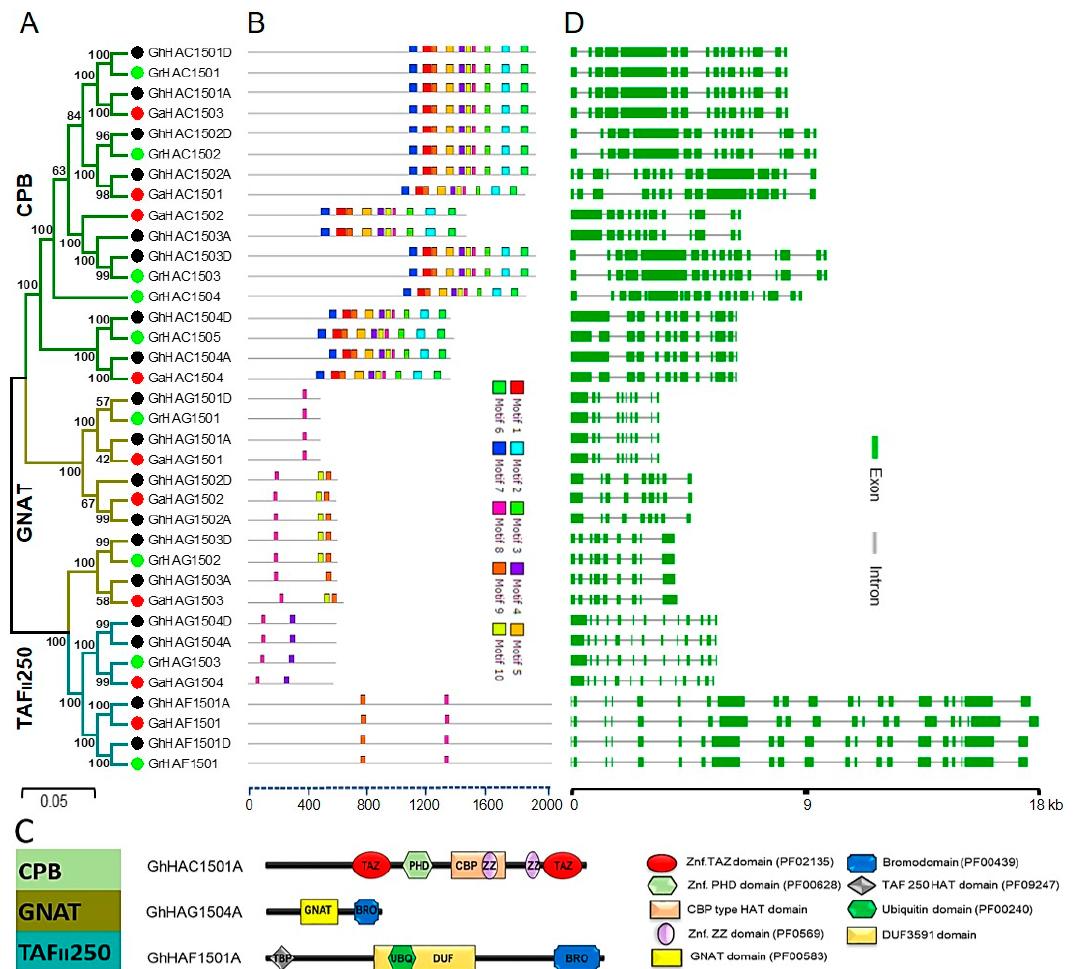
Figure 2. Phylogenetic relationships, conserved motifs, domain organization, and gene structure analysis of HATs in Gossypium hirsutum , Gossypium raimondii and Gossypium arboretum . ( A ) The unrooted phylogenetic tree was constructed using MEGA 6 by the NJ method, and the bootstrap analysis was performed with 1000 replicates. The HAT proteins from G. hirsutum , G. raimondii , and G. arboretum were marked with black, green and red dots, respectively. The branches of each subgroup were indicated in a specific color. ( B ) Motif identification analysis in HAT proteins from G. hirsutum , G. raimondii and G. arboretum . Each motif is shown in unique color, and the regular expression and sequences of the 1–10 motifs are listed in Figure S1. ( C ) Domain organization of HAT proteins from G. hirsutum , G. raimondii and G. arboretum . One representative of each subgroup of HAT from G. hirsutum is presented. ( D ) The intron / exon structure of HAT genes from G. hirsutum , G. raimondii and G. arboretum . The green boxes and grey lines represent exons and introns, respectively.